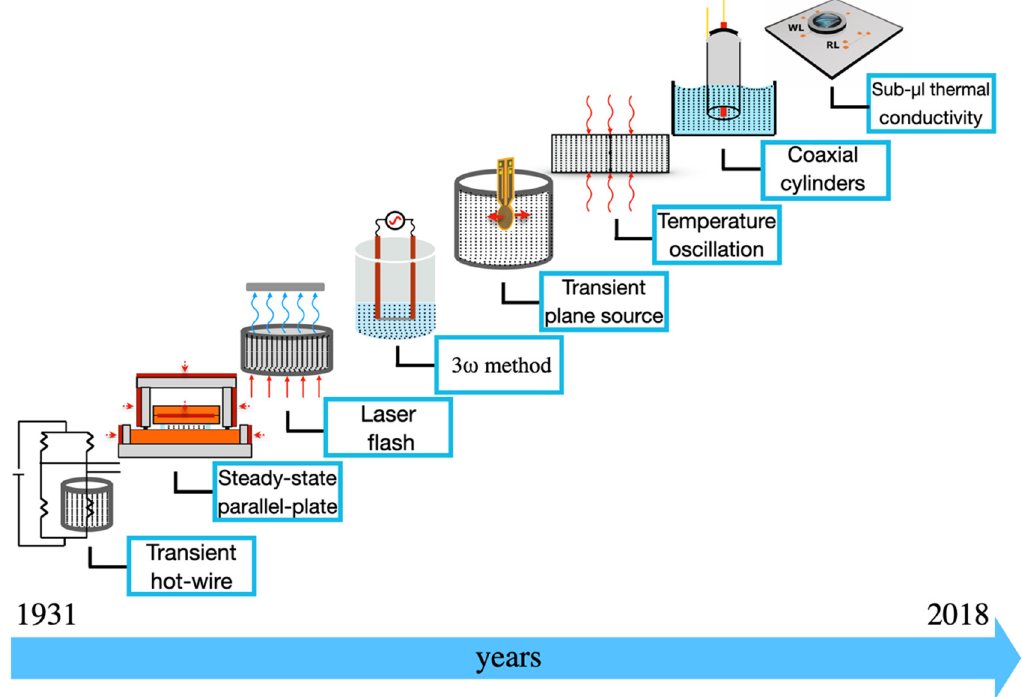
Figure 2. Schematic diagram of the main techniques to measure the thermal conductivity of NFs.